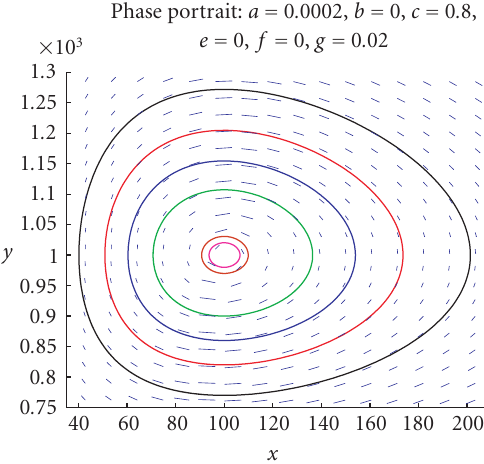
Figure 3.5. Phase portrait showing the vector field for b = e = f = 0, c < 1 and the periodic orbits around the nonlinear center at x 0 = 100, y 0 = 1000, as given by (3.3). The orbits are described by the closed form relation (3.17).